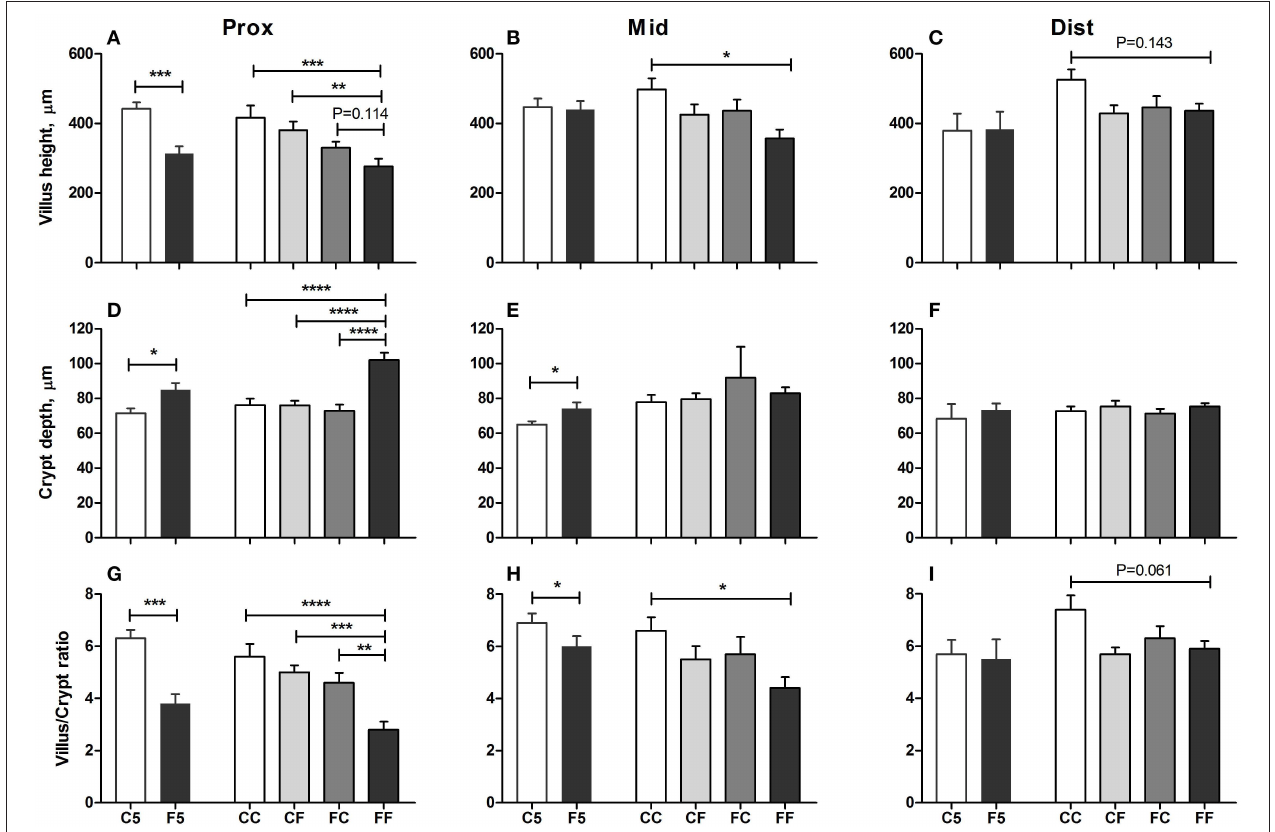
FIGURE 4 | Mucosal morphology. Villus heights in the proximal, middle, and distal small intestine (A–C) , crypt depth in the proximal, middle, and distal small intestine (D–F) , villus/crypt ratio in the proximal, middle, and distal small intestine (G–I) . Values (means ± SEM) designated with asterisks are significantly different, * P < 0.05, ** P < 0.01, *** P < 0.001, **** P < 0.0001. n = 11 for C5 and F5 groups and n = 12–14 for CC, CF, FC, and FF groups. C5, colostrum feeding until day 5; CC, colostrum feeding until day 9; CF, 4 days colostrum feeding followed by formula feeding until day 9; F5, formula feeding until day 5; FC, 4 days formula feeding